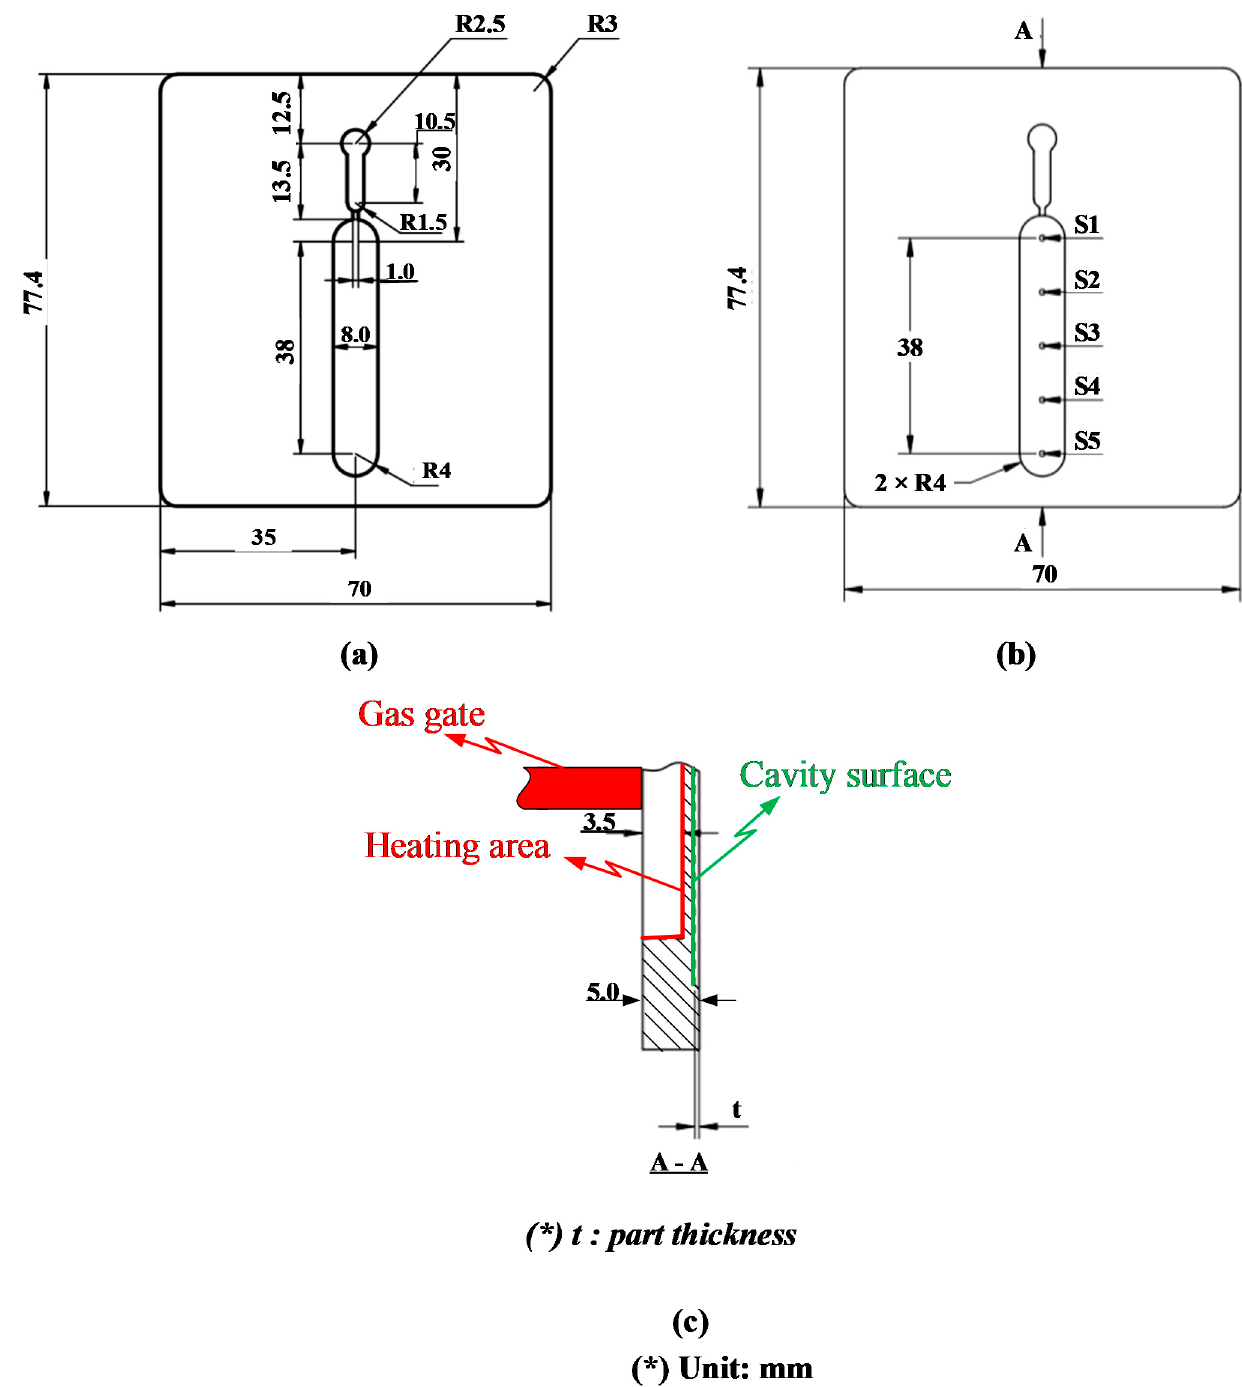
Figure 5. Insert dimension ( a ) with the sensor locations S1 to S5 ( b ) and the heating surface of the insert ( c ).